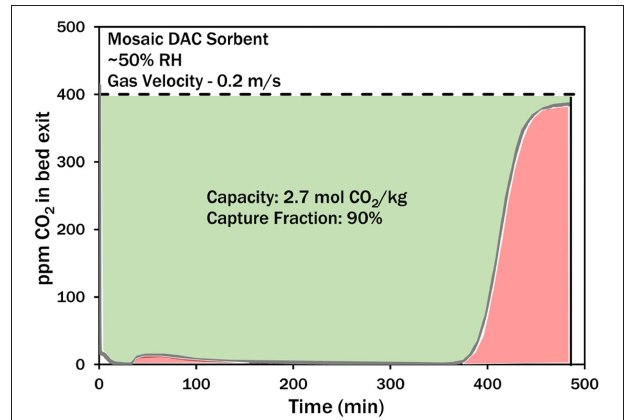
FIGURE 1 | Performance of Mosaic’s DAC solid sorbent under ∼ 400 ppm CO 2 in air, ∼ 25 ◦ C and 40–50% RH. Shaded areas are included to guide the eye, with green corresponding to CO 2 that is retained by the material and red corresponding to CO 2 that “slips” through the bed